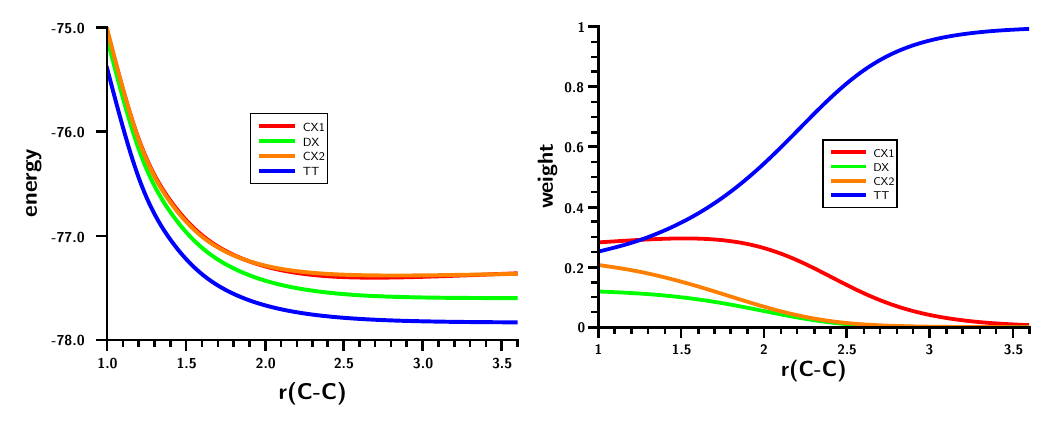
Figure 5. Carbene dimerization. Energies ( left ) and weights ( right ) of the six most important FO-CSFs. Energy in Hartrees; bond length in